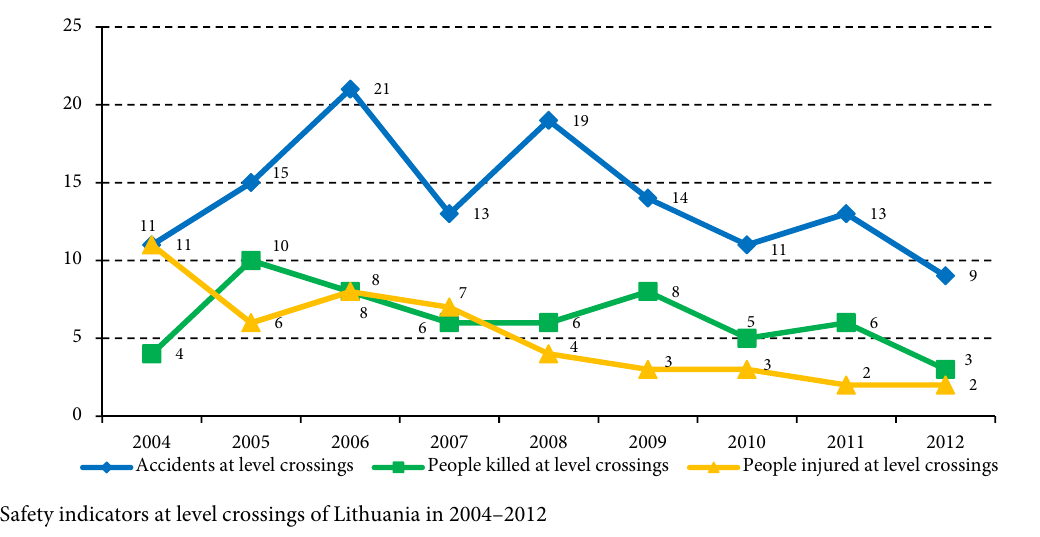
Fig. 2. Safety indicators at level crossings of Lithuania in 2004–2012